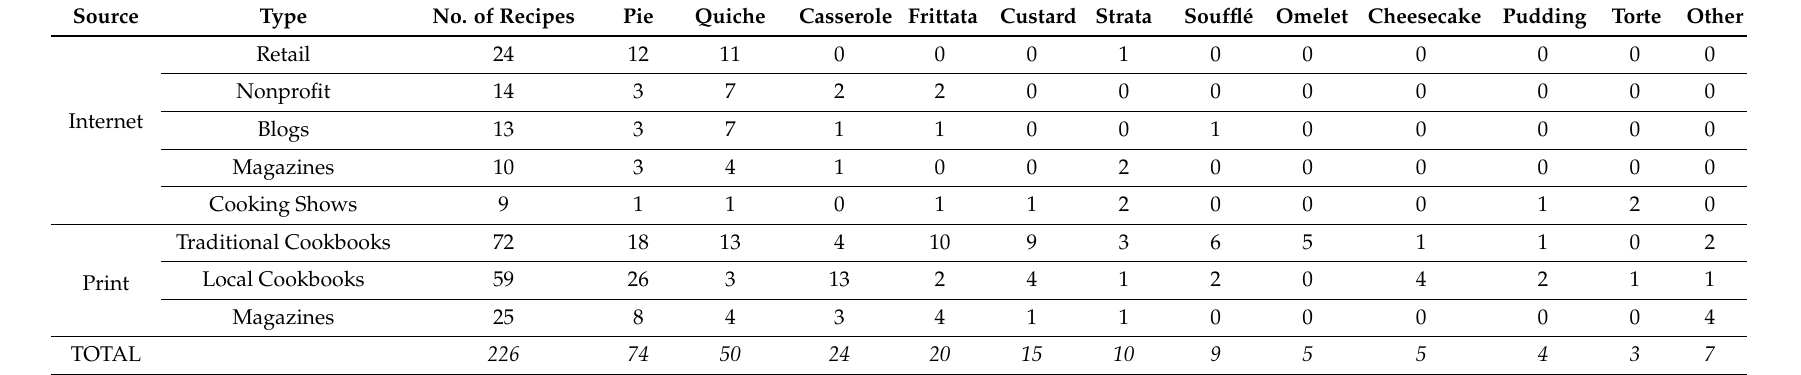
Table 1. Sources of recipes used in the study, along with types of recipes from each